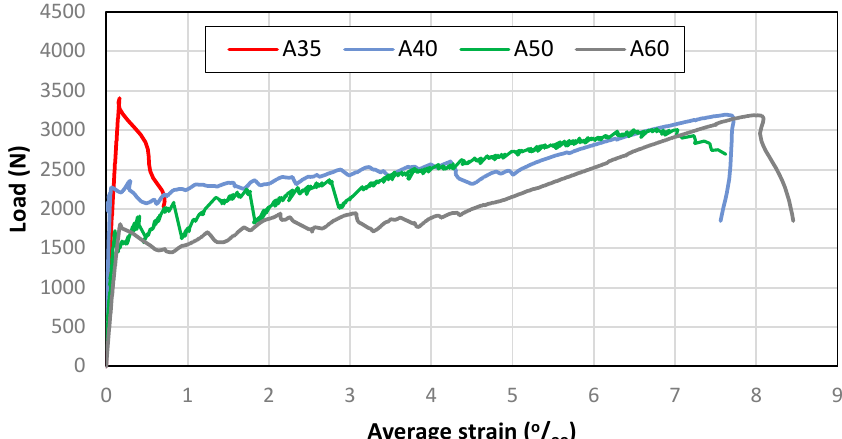
Figure 8. Load-deformation curves of TRC ties.